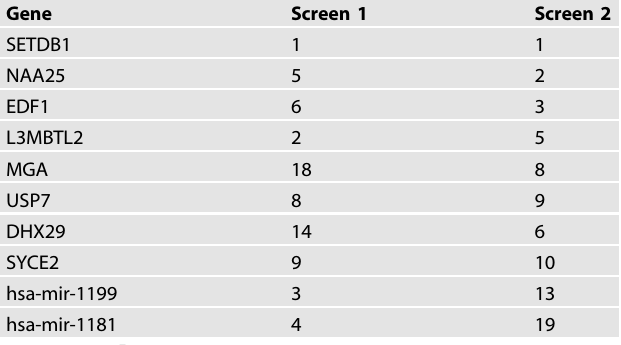
Table 1. Comparison of the top hits in the two screen repeats ranked by the MAGeCK